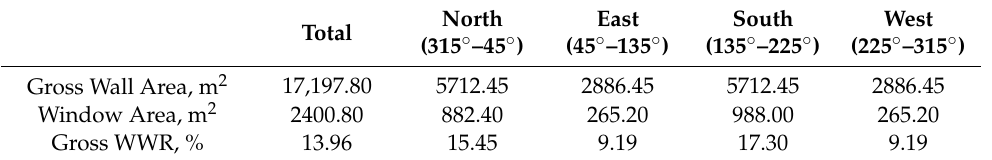
Table 4. Original window-to-wall ratios of the building.